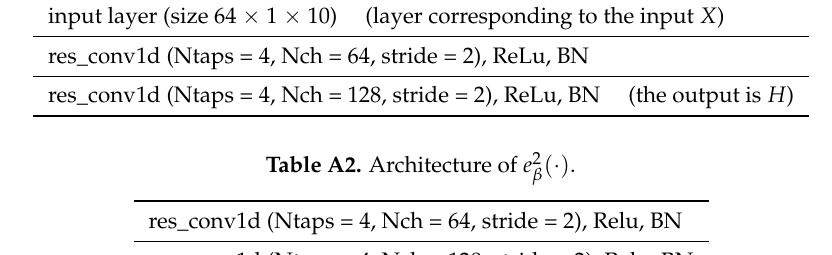
Table A2. Architecture of e 2